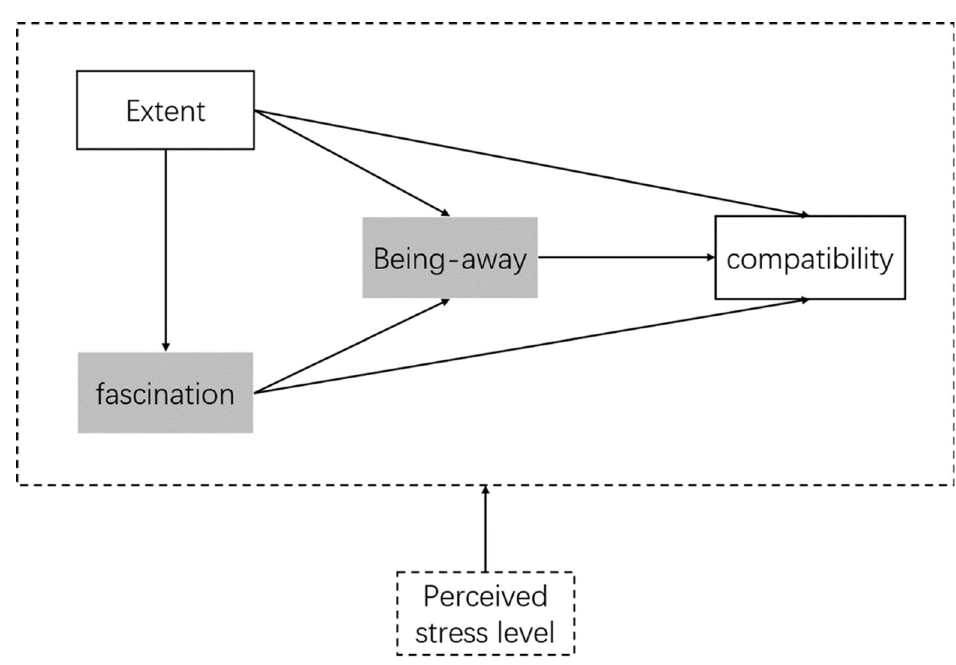
Fig 1. Hypothesized relationships among restorative components of natural